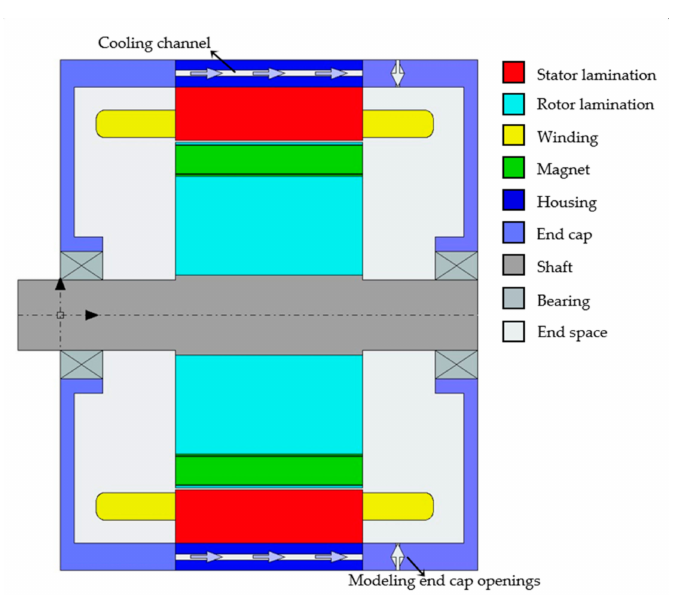
Figure 5. Baseline motor thermal